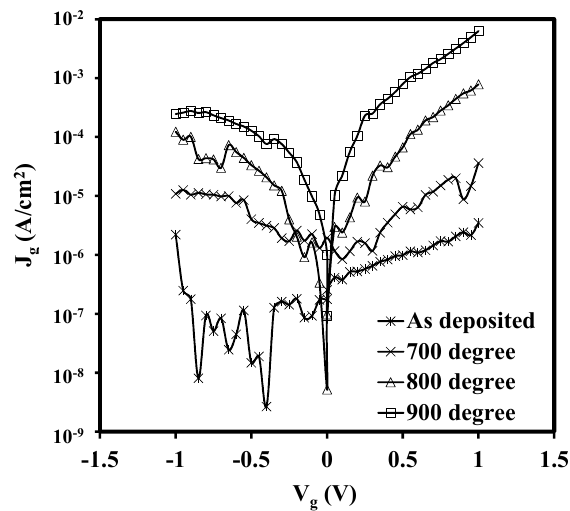
Figure 9. Gate leakage current versus gate voltage for the four samples. The thickness of